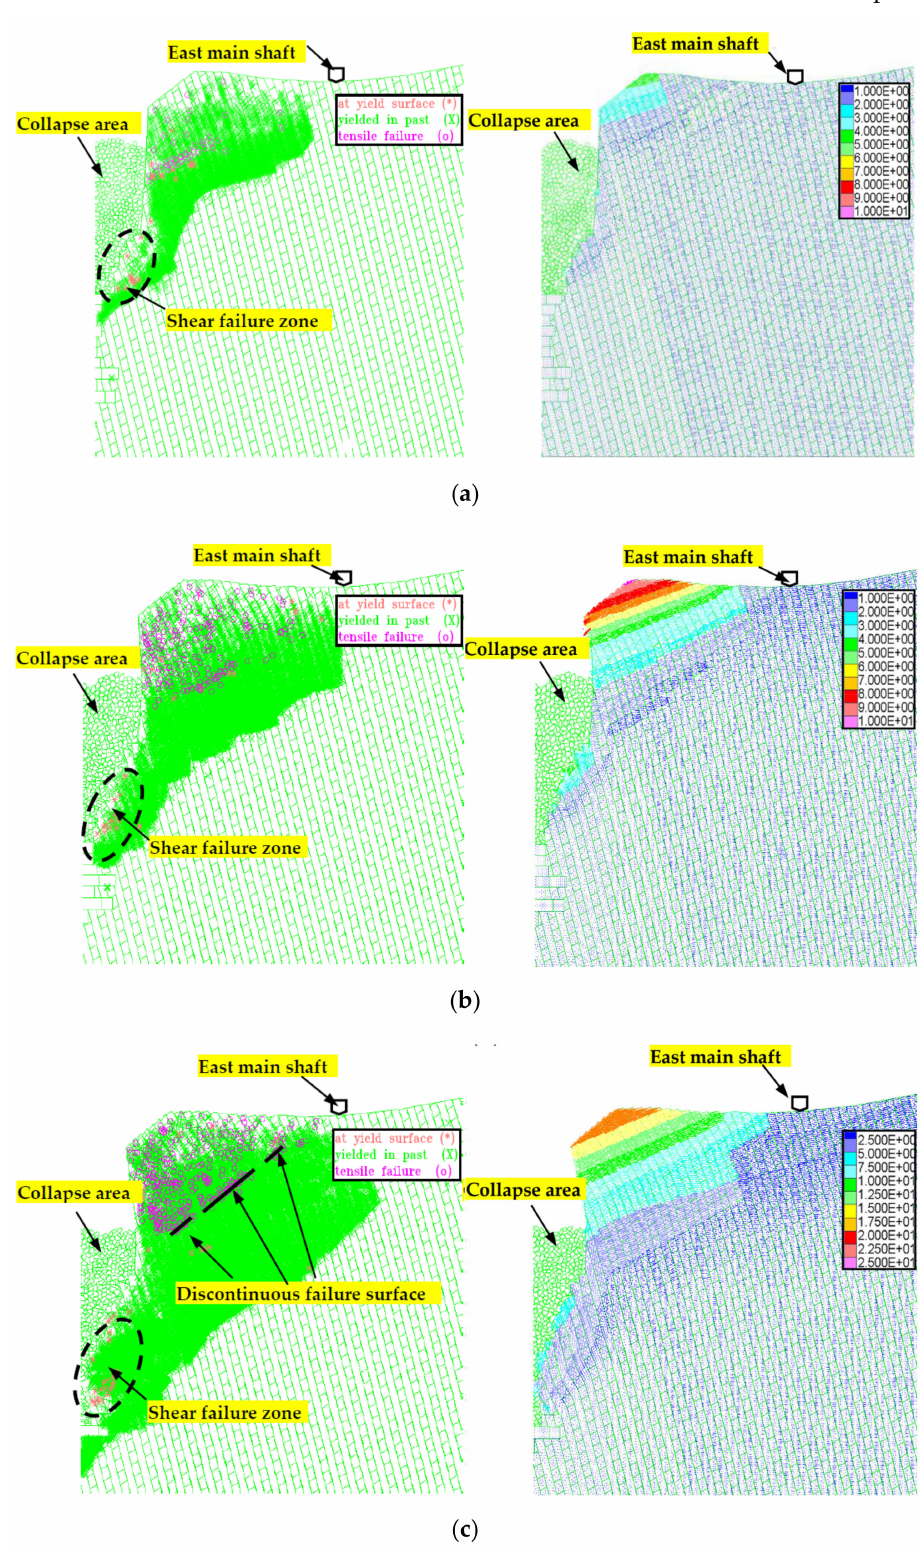
Figure 12. Plastic failure zones and displacement vector diagrams for the footwall at different excavation levels. The three stages shown correspond to depths of: ( a ) − 232 m, ( b ) − 288 m, and ( c ) − 358